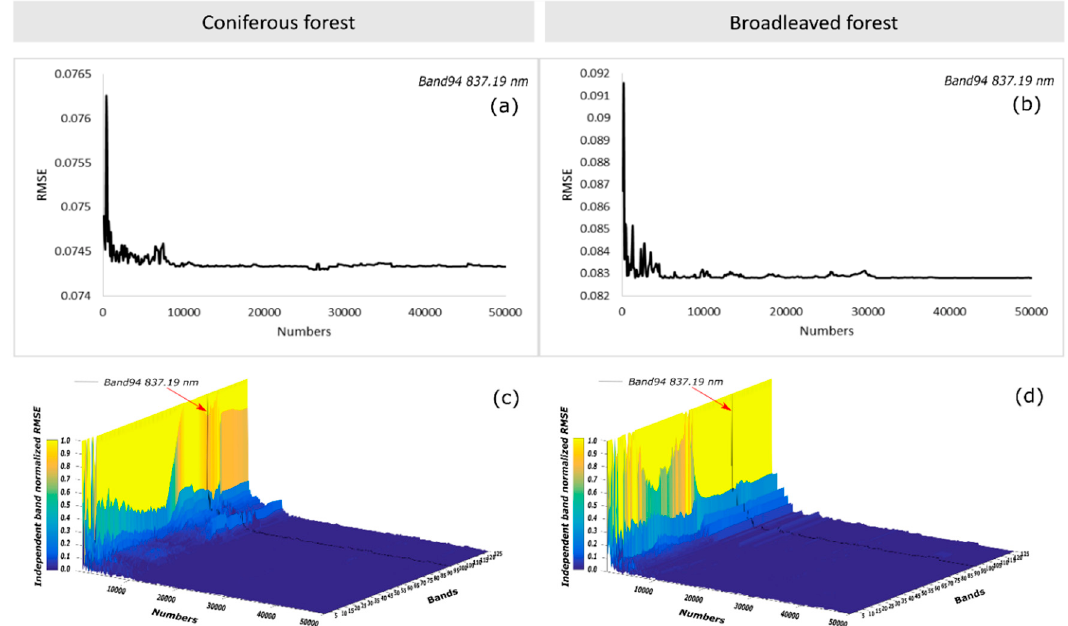
Figure 5. Optimal number of selected pixels for BRDF model building of band 94 (837.19 nm). ( a ) and ( b ) show the root mean square error (RMSE) between observed and model simulated reflectance of coniferous and broadleaved forest, respectively; ( c ) and ( d ) respectively indicate the independent band normalized RMSE (corresponding to selected number of pixels n ) for all the bands of coniferous and broadleaved forest, with independent band 94 normalized RMSE plotted in black.